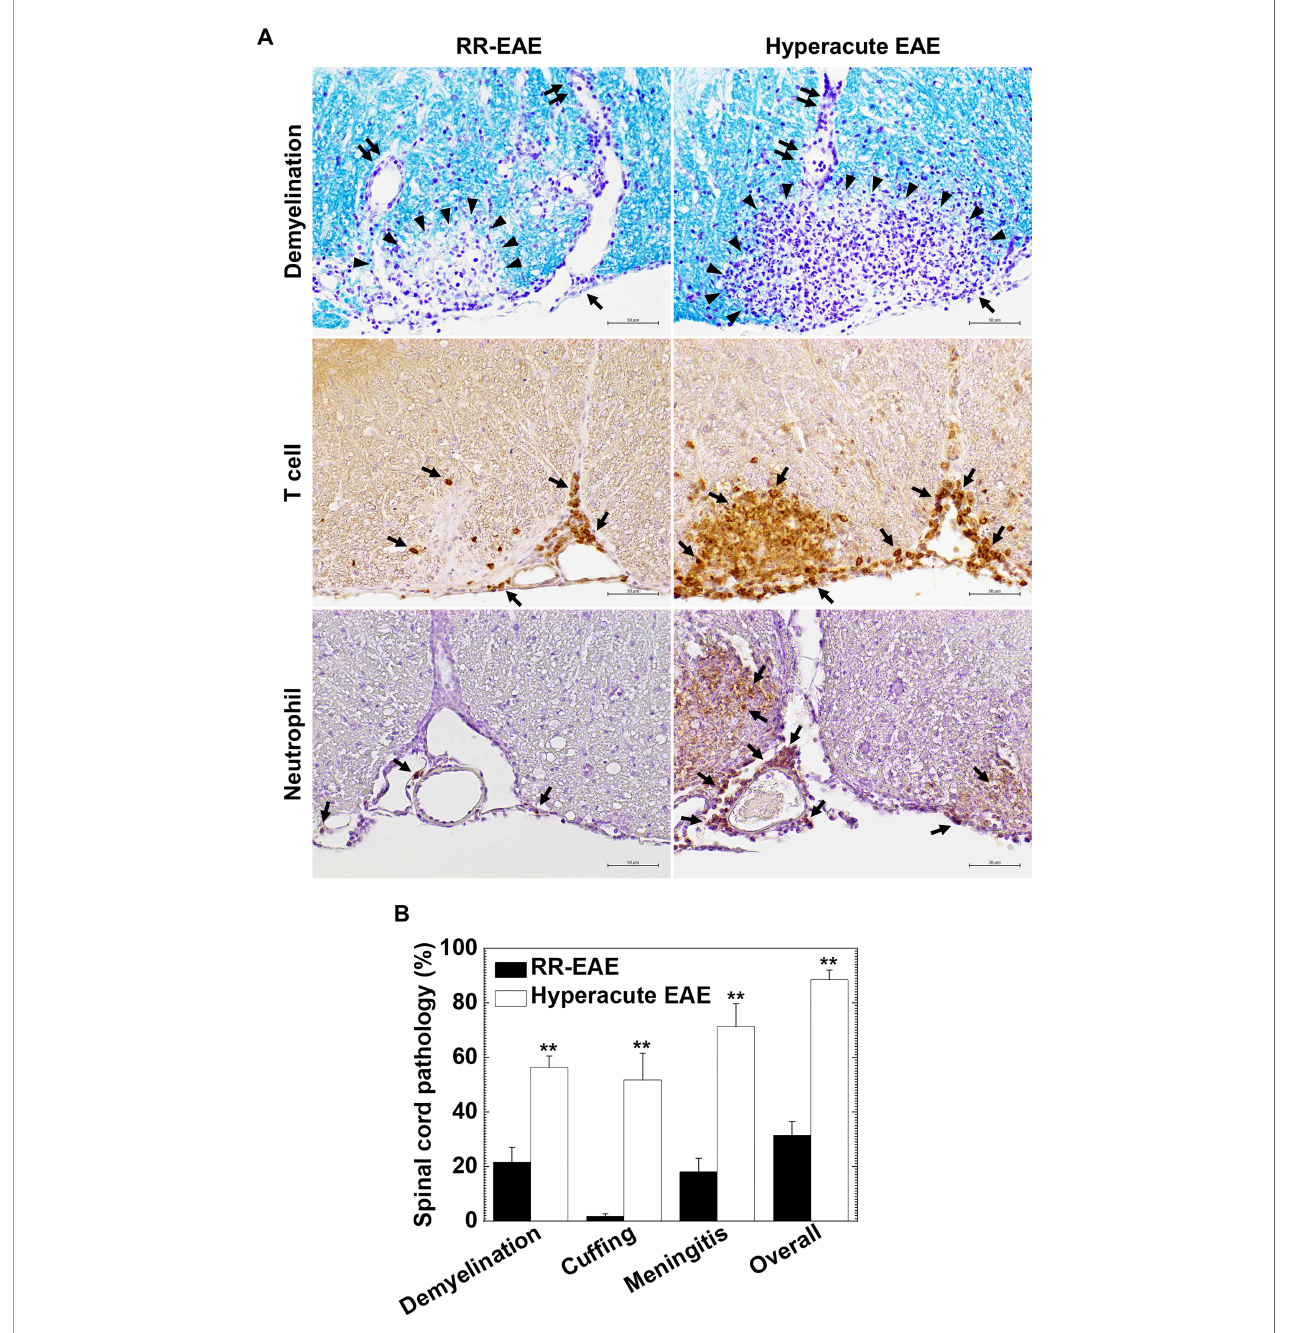
FIGURE 2 | Curdlan-induced hyperacute EAE mice developed more severe demyelinating lesions with massive in fi ltration of T cells and neutrophils in the spinal cord. (A) We visualized myelin by Luxol fast blue stain (top panels) and in fi ltration of T cells and neutrophils by immunohistochemistry against CD3 (middle panels) and Ly-6G (bottom panels), respectively, in RR-EAE (left) and hyperacute EAE (right). In RR-EAE, we observed mild to moderate demyelination around perivascular spaces or subpial areas with in fi ltration of mononuclear cells (MNCs), mainly composed of CD3 + T cells; only a few neutrophils were observed in the meninges. In hyperacute EAE, we found severe demyelination with massive parenchymal in fi ltration of MNCs and polymorphonuclear cells (PMNs), which were composed of CD3 + T cells and Ly-6G neutrophils, respectively. In Luxol fast blue staining, arrowheads, paired arrows, and arrows indicate demyelination, perivascular cuf fi ng (in fl ammation), and meningitis, respectively. In immunostaining, arrows indicate CD3 + T cells (middle panels) and Ly-6G + neutrophils (bottom panels). Tissue sections are representative of fi ve to eight mice per group. Scale bar = 50 m m. (B) Neuropathology scores of the spinal cords in RR-EAE (black bar) and hyperacute EAE (white bar). Hyperacute EAE mice had signi fi cantly higher pathology scores than RR-EAE in all pathology classes: demyelination, perivascular cuf fi ng (in fl ammation), meningitis, and overall pathology. Values are the mean + standard error of the mean (SEM) of six to eight mice per group. ** P < 0.01, Student ’ s t